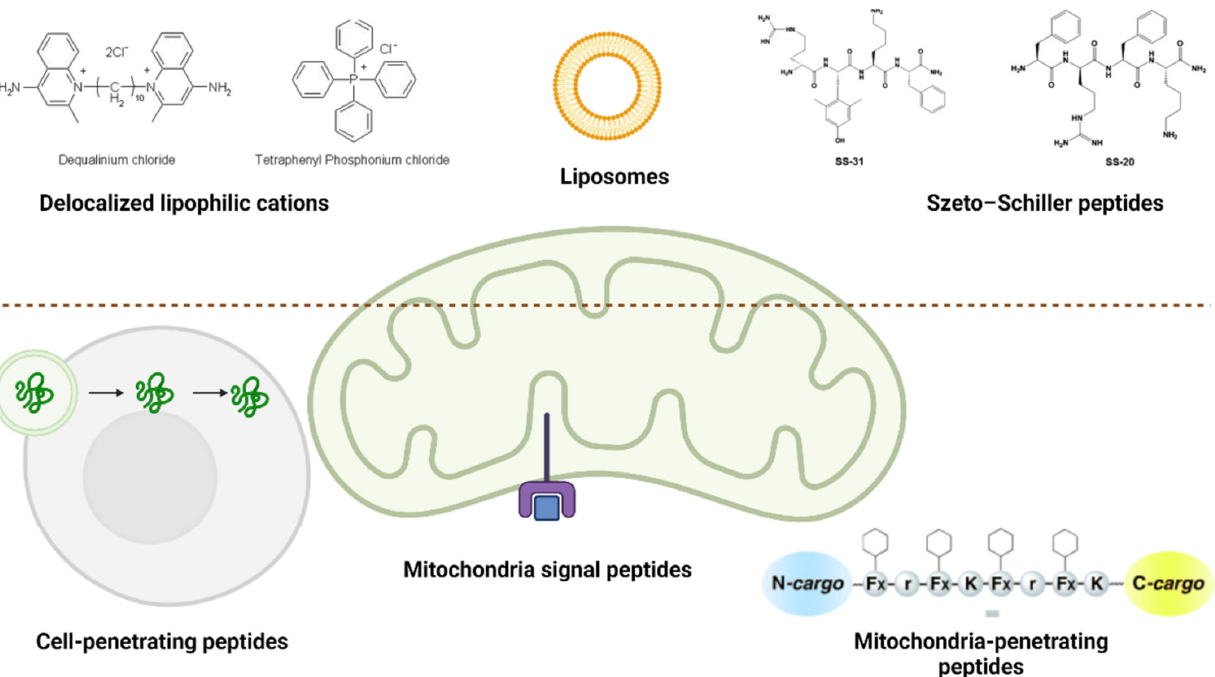
Figure 2. Passive (up the dotted line) and active (down the dotted line) mitochondria delivery